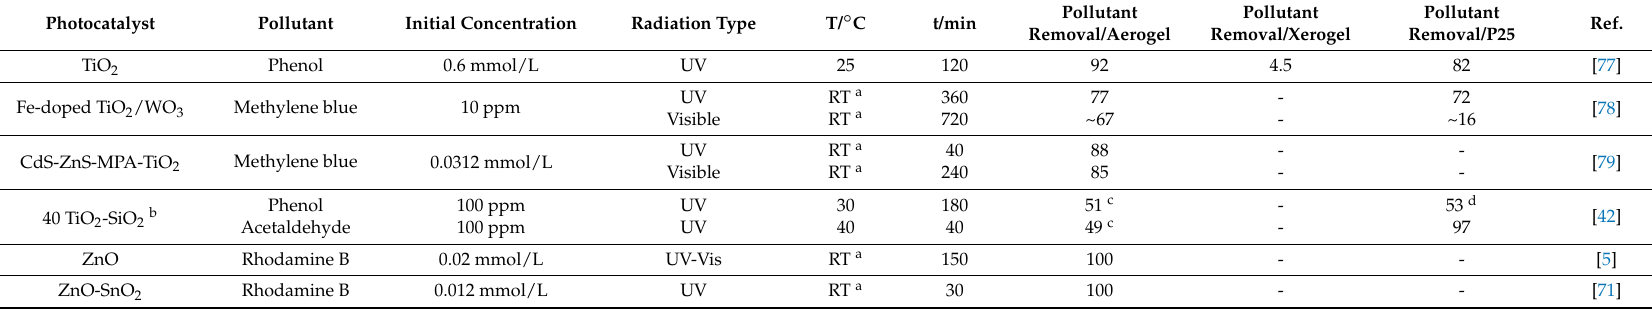
Table 2. Performance in the degradation of pollutants of selected metal-oxide-based photocatalysts prepared by scCO 2 -assisted sol-gel